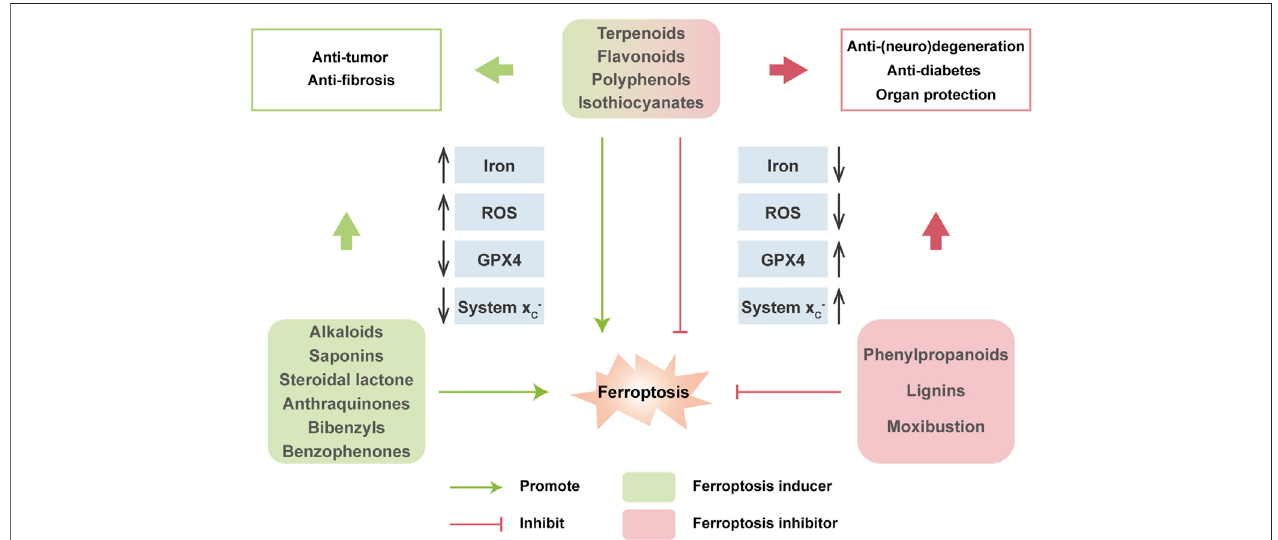
FIGURE 4 | Multiple effects of natural compounds regulating ferroptosis. Alkaloids, saponins, steroidal lactone, anthraquinones, bibenzyls and benzophenones can induce ferroptosis with anticancer and anti fi brosis functions. In contrast, phenylpropanoids and ligins alleviate (neuro)degeneration and prevent irreparable organic damage via antagonizing ferroptosis. Interestingly, terpenoids, fl avonoids, polyphenols and isothiocyanates have dual effects on ferroptosis which depends on different disease contexts.